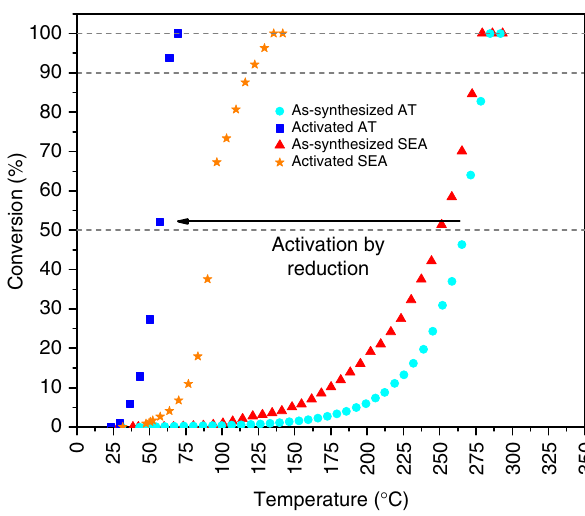
Fig. 1 CO oxidation light-off curves for 1wt.%Pt/CeO 2 catalysts. The activity of the catalysts synthesized by AT and SEA methods was measured before and after activation. TAPN was used as precursor